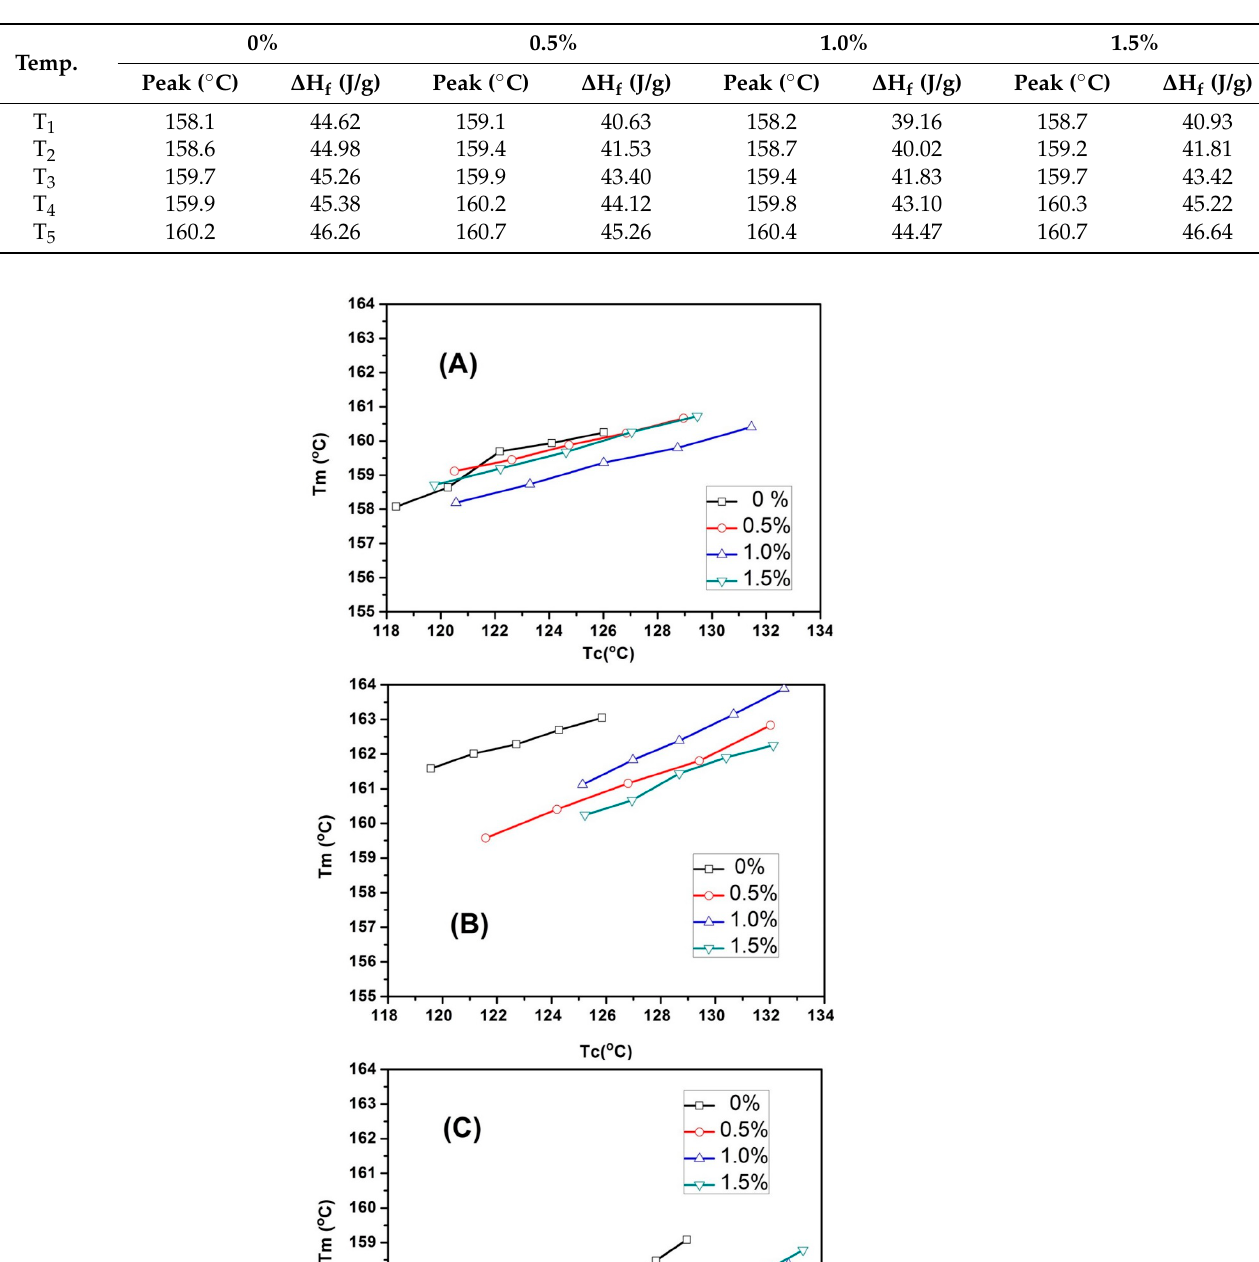
Table 4. The melting peak and melting enthalpy ( ∆ H f ) list of the twice-heating curve under isothermal crystallization on PLLA-PEG200 copolymer and PLLA-PEG200/o-MMT nanocomposites.